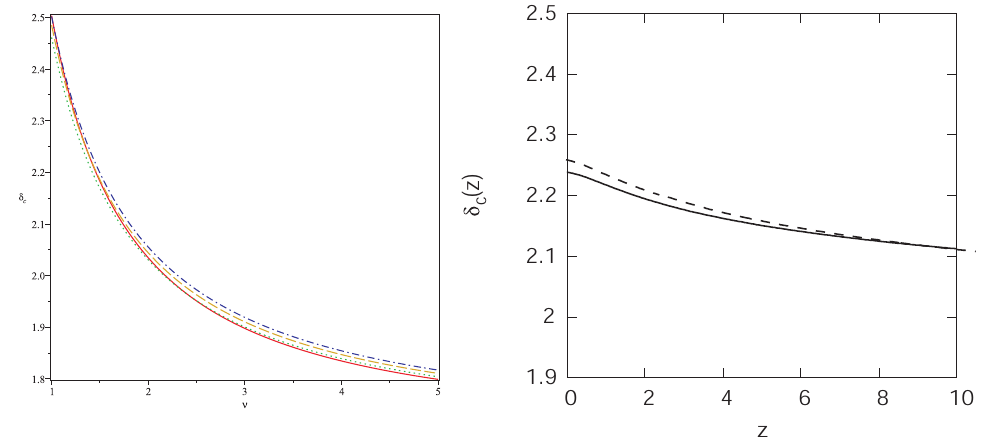
Figure 1. The collapse threshold δ c ( ν ) vs ν . Left panel: the solid line is the shows the SMT result, the short-dashed line that of Del Popolo & Gambera (1998), taking into account the effect of the tidal field, the long-dashed the result of Del Popolo (2006a,b) taking into account the effect of the tidal field, and the cosmological constant, and the dot-dashed line is δ c ( ν ) taking into account the effect of the tidal field, the cosmological constant, and DF (Del Popolo 2006b). Right panel: the collapse threshold in terms of redshift when angular momentum and Λ is taken into account (solid line) for a mass M = 10 11 h −1 M ⊙ . The dashed line represents the same quantity when dynamical friction is taken into